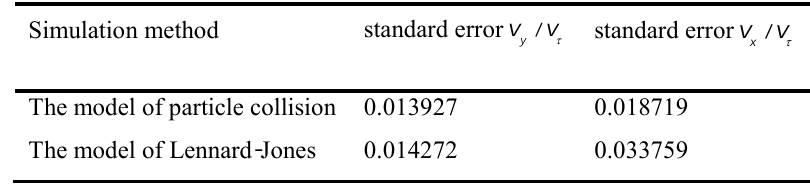
The standard errors of vertical velocities and horizontal